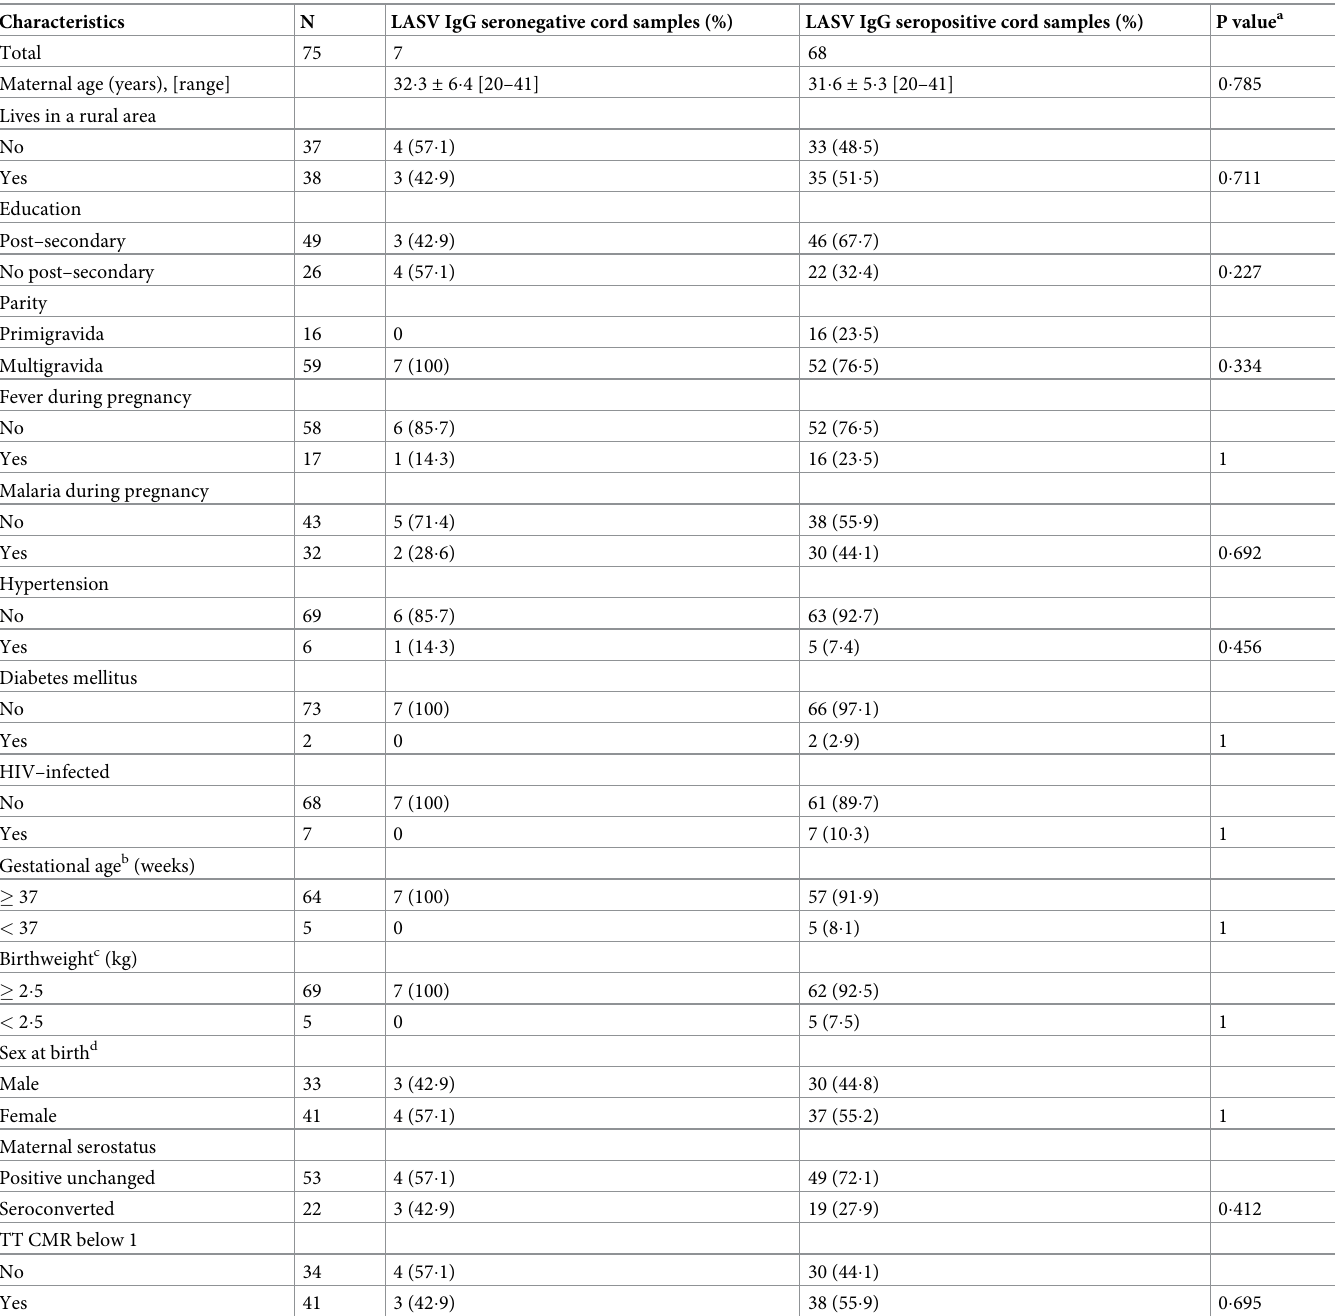
Table 4. Factors associated with cord LASV IgG seronegativity (cord index value � 0.9).